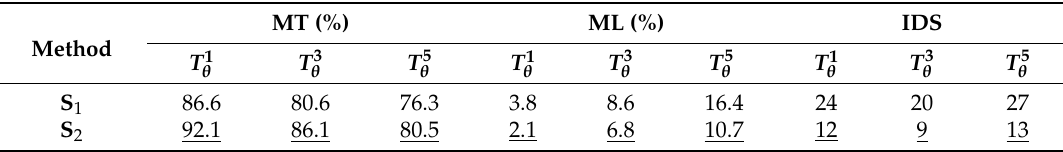
Table 4. Comparison of tracking results on sequence EgTest02 with different detection thresholds T v